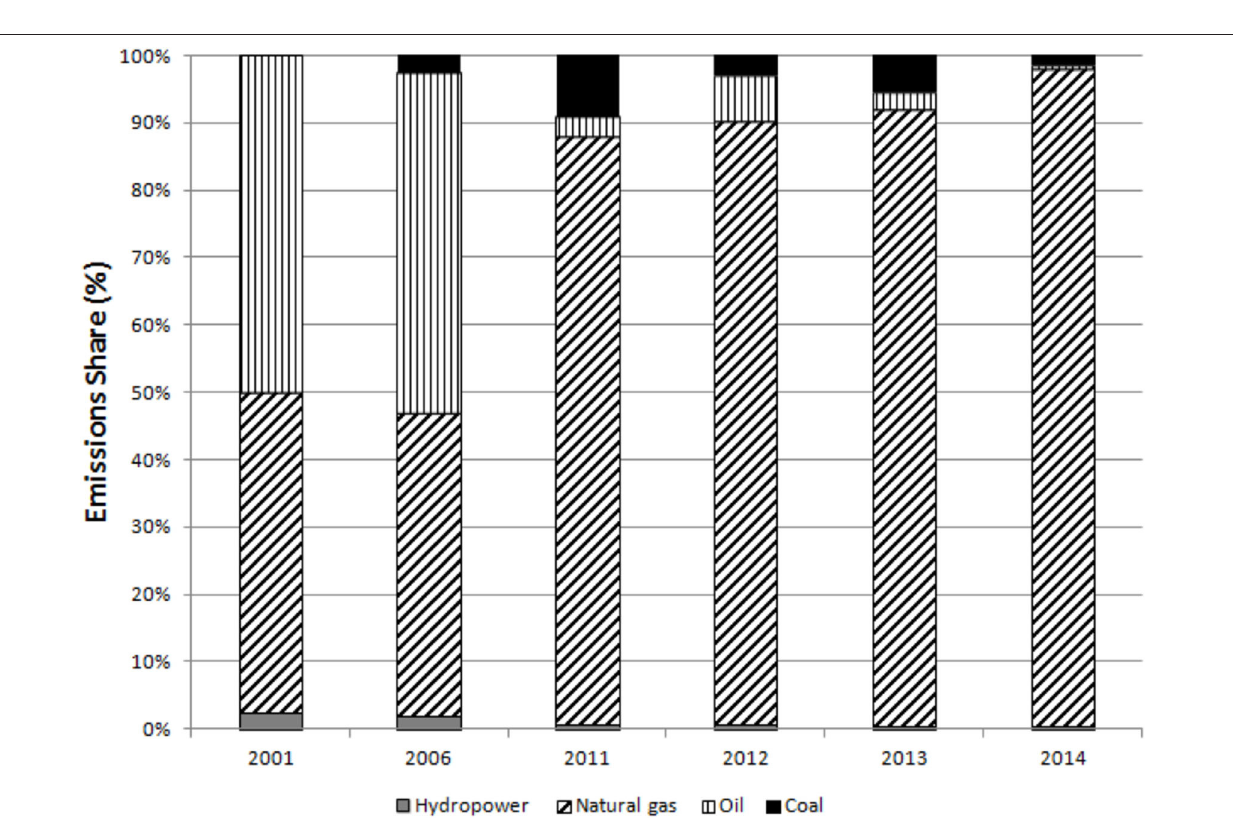
FIGURE 5 | Evolution of the energy generation mix for years 2001–2014.